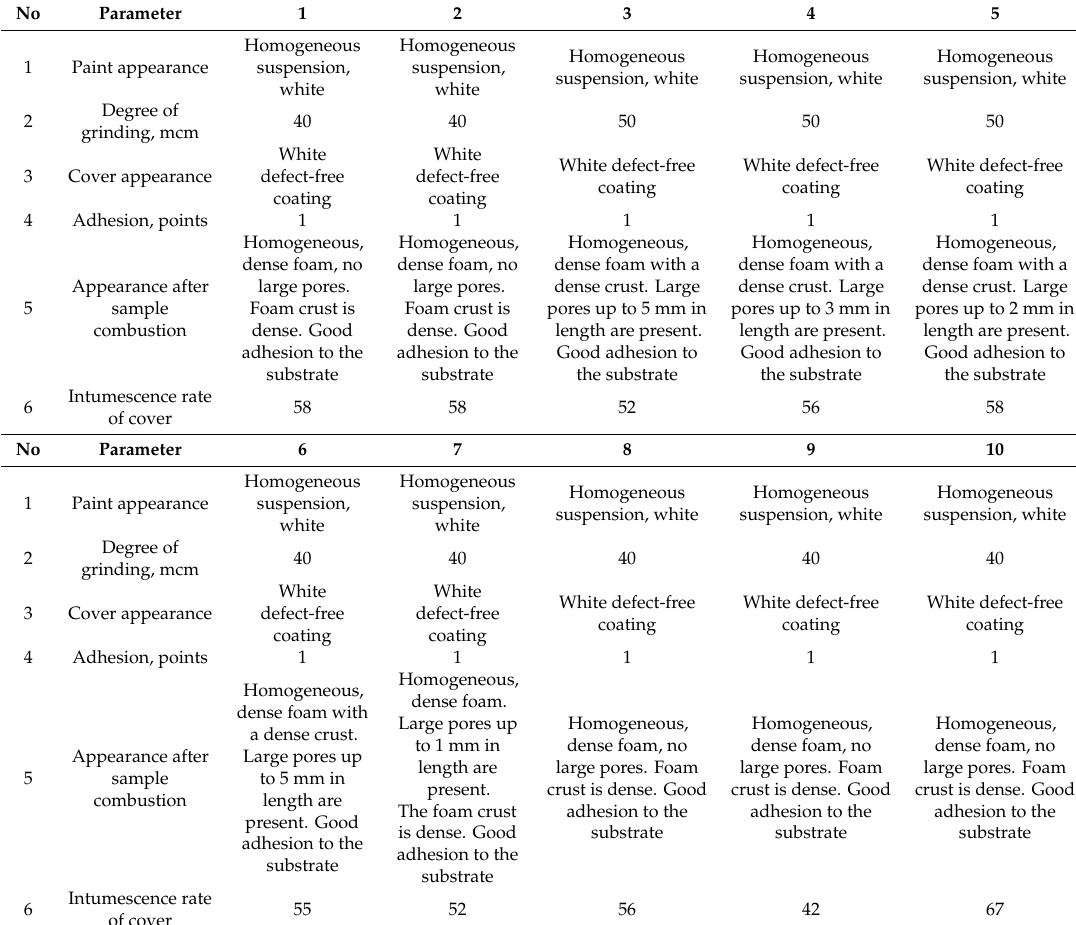
Table 3. Physicochemical parameters of the fireproof paint samples with di ff erent PFA brands.